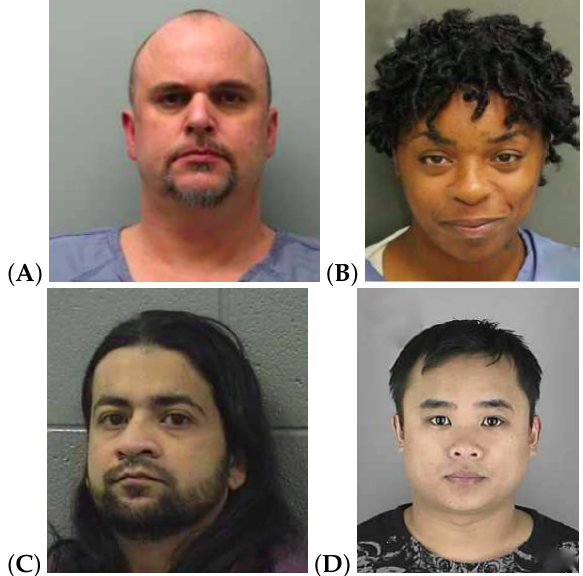
Figure A1. Pictures of characters in the story shown to the study participants: ( A ) is the purse- snatcher, ( B ) is the victim and ( C ) and ( D ) are the